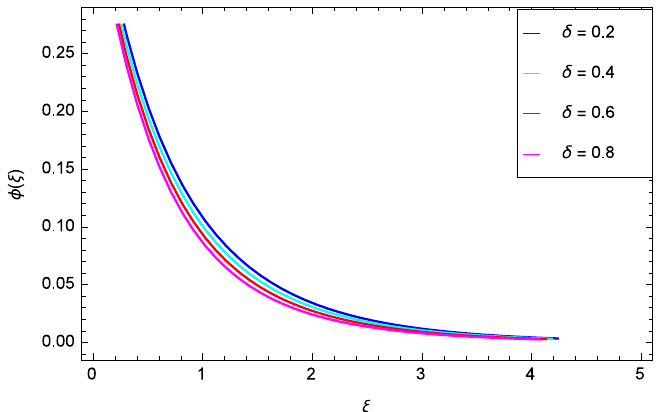
Figure 19. Impact of the chemical reaction parameter δ on concentration φ ( ζ ) .